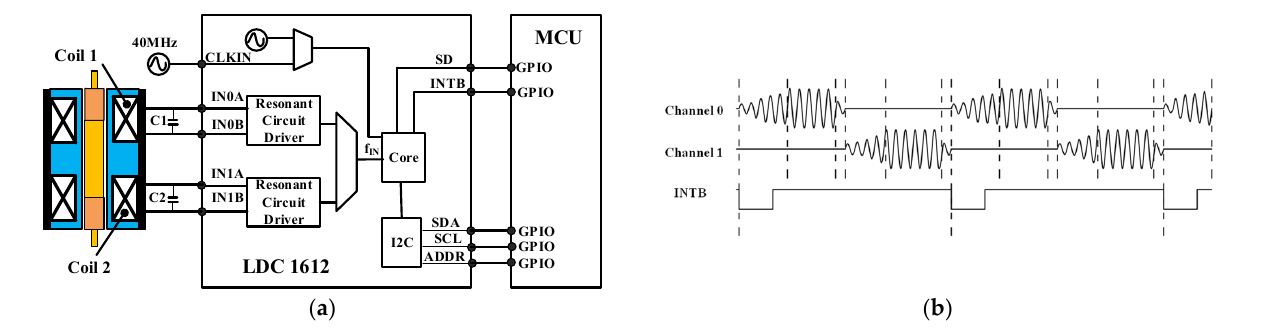
Figure 5. Signal conditioning circuit based on LDC 1612; ( a ) Functional block diagram of the signal conditioning circuit; ( b ) Control timing.